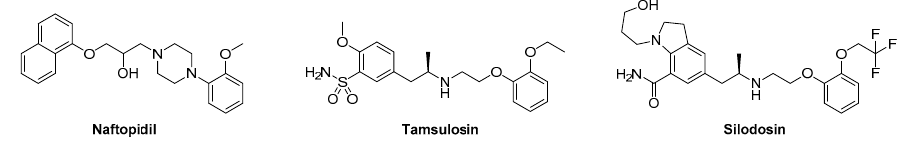
Figure 1. Chemical structures of selective α 1A - and α 1D -AR antagonists.